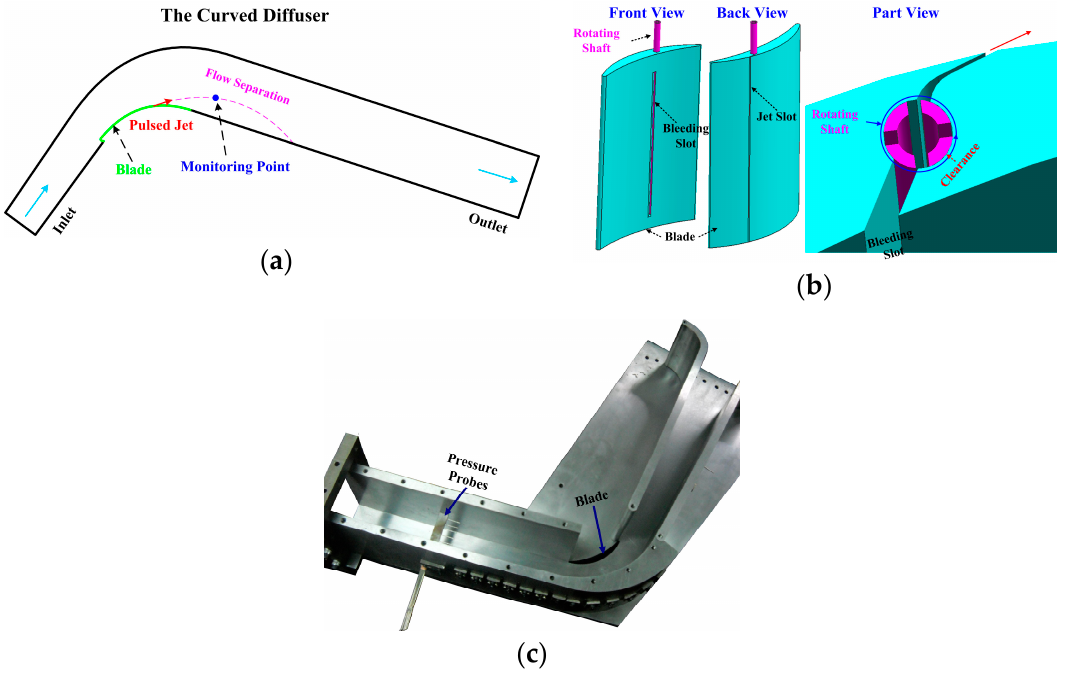
Figure 1. Diagram of the ( a ) curved diffuser and ( b ) pulsed jet flow control device; ( c ) experimental devices.